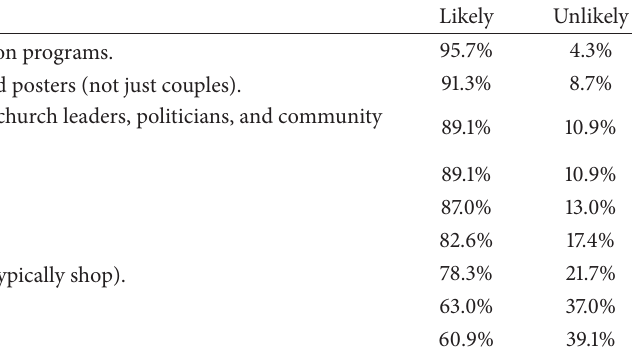
Table 3: Likelihood of strategies successfully increasing male participation in HARC programs. Strategy